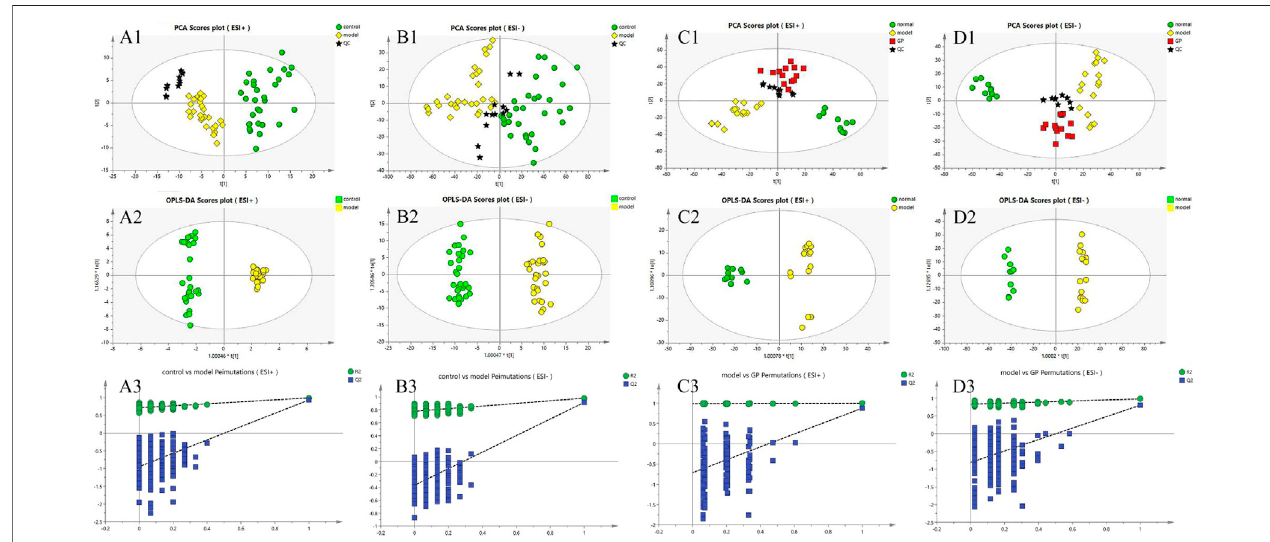
FIGURE 1 | PCA and OPLS-DA and permutation score plots (A1 – A3) : clinical plasma sample of the control and model group, ESI+; (B1 – B3) : clinical sample of model and control, ESI; (C1 – C3) : plasma samples in mice of the control, model, and GP groups, ESI+; (D1 – D3) : plasma samples in mice of the control, model, and GP groups, ESI −